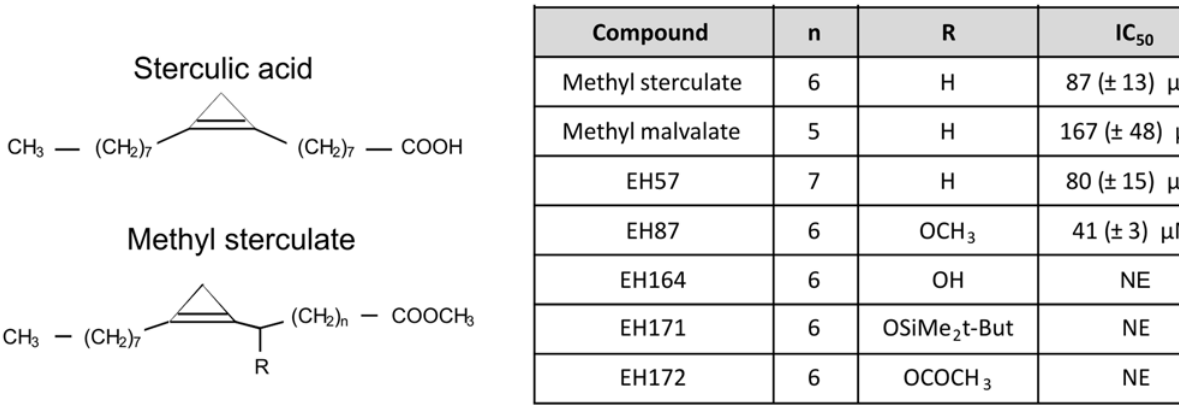
Figure 7. Structure and antimalarial activity of methyl sterculate and its analogs. Chemical structure of sterculic acid, as well as methyl sterculate (MeSter) and some derivatives. Inhibition of the intraerythrocytic growth of P. falciparum 3D7 by each compound is expressed as the mean 6 SEM IC 50 value (in m M). Each compound was tested in duplicate on three separate occasions. NE, no effect on parasite viability was observed at the highest concentration tested (1